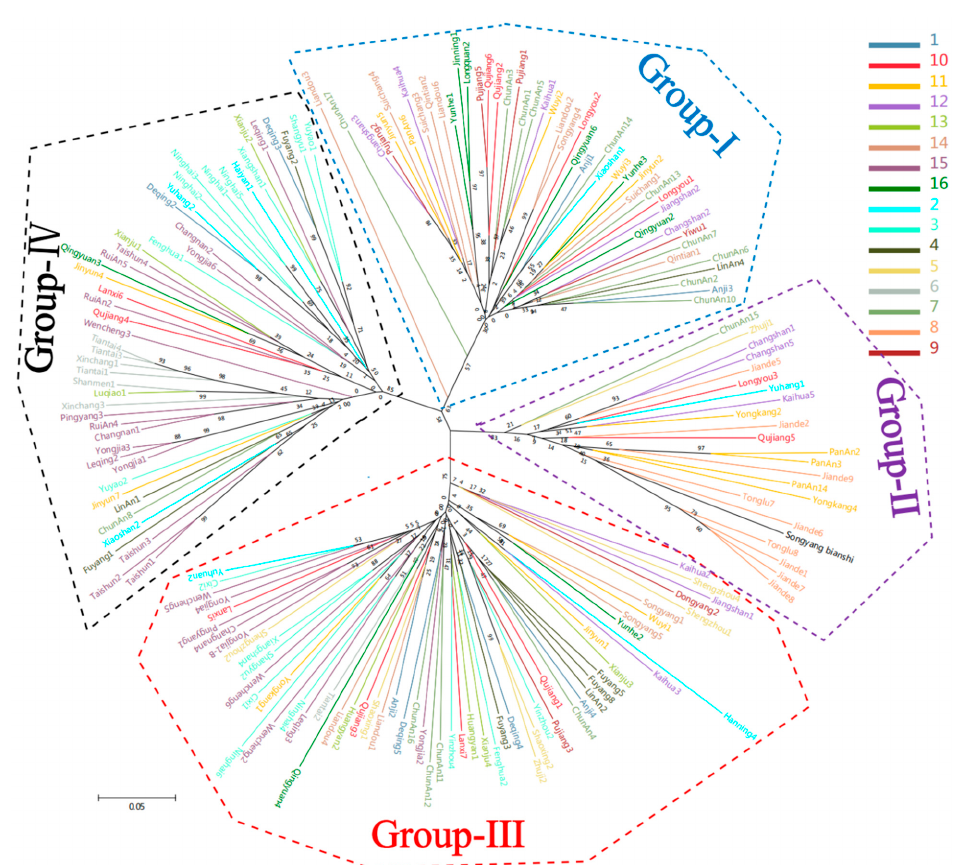
Table 6. Comparison of genetic diversity parameters for the germplasm clusters.